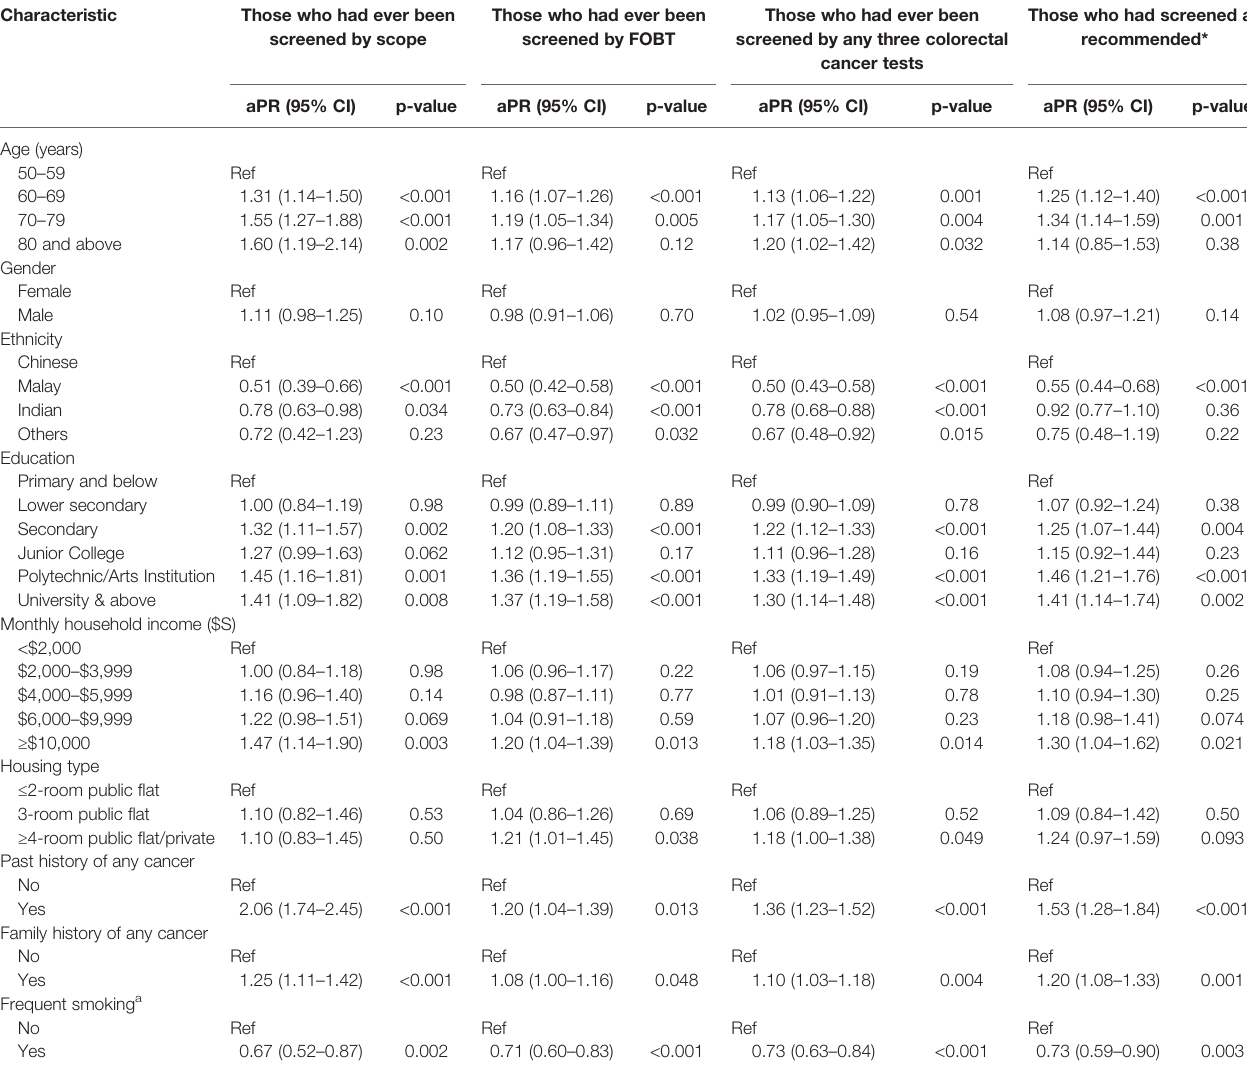
TABLE 4 | Adjusted prevalence ratio (aPR) estimates for characteristics associated with participation in colorectal cancer